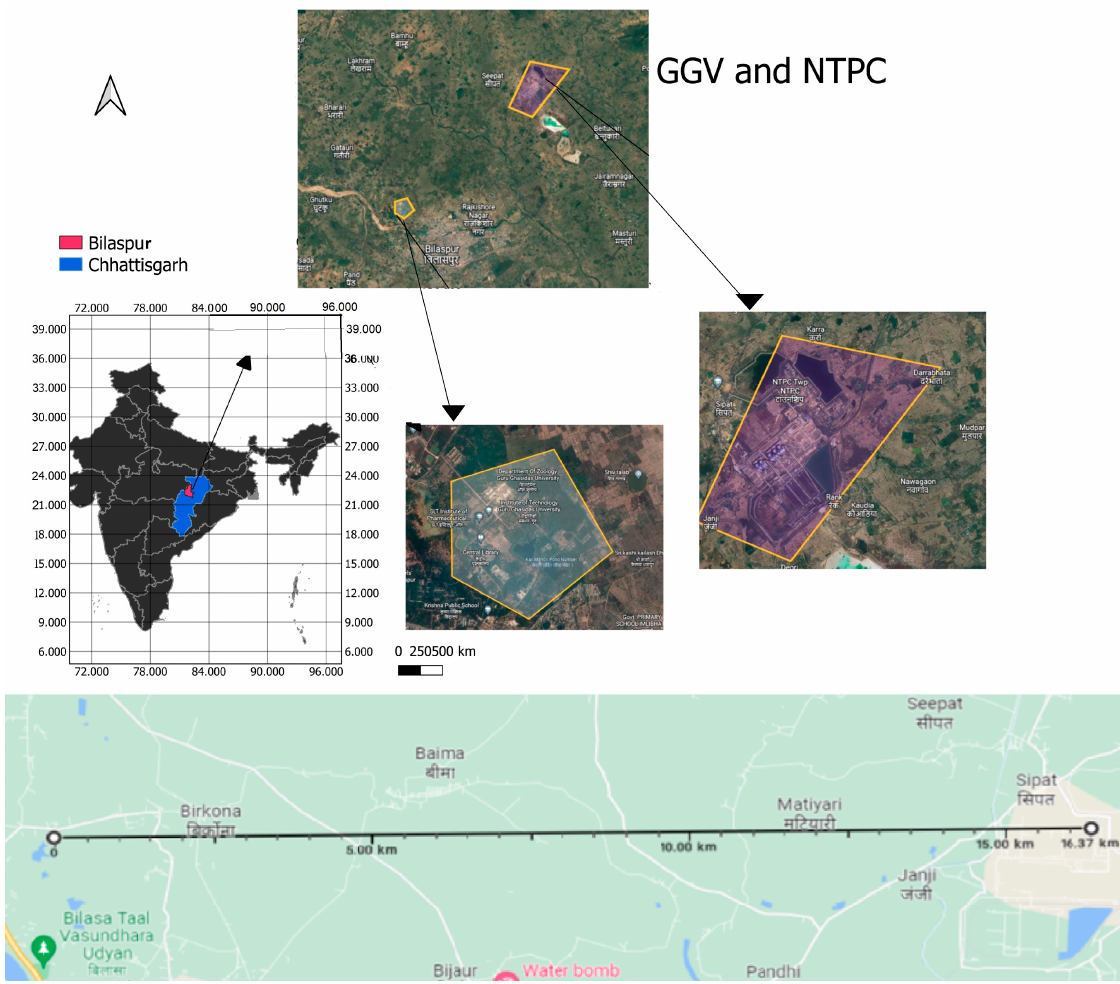
Figure 1 . Study site location. GIS, 2022 . Figure 1. Study site location. GIS,